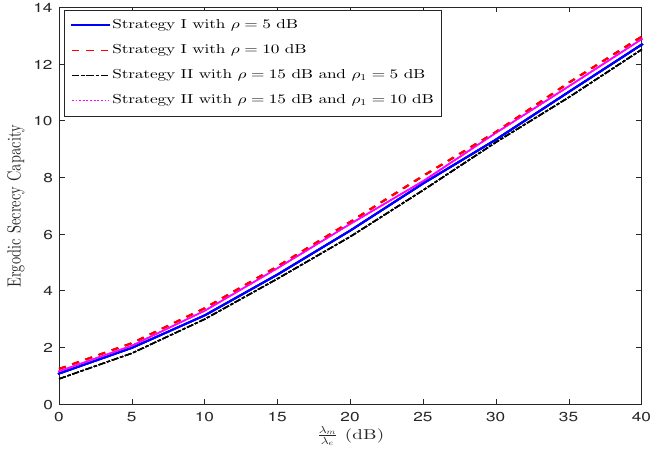
Figure 11. ESC performance versus λ m